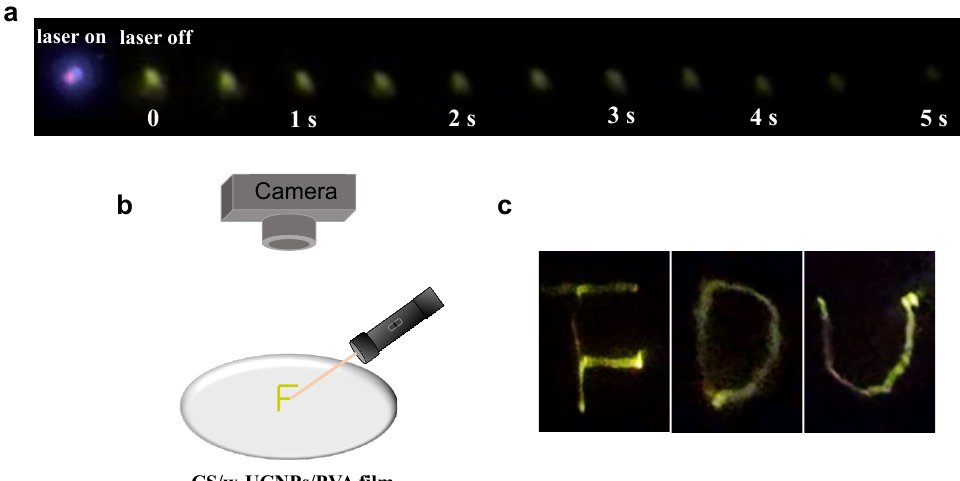
Figure 4. ( a ) Photographs of the long-lasting luminescence of the CS/w-UCNPs/PVA film with the 980 nm laser excitation on and off; ( b ) schematic illustration of laser writing; ( c ) photographs of laser writing of capital letters “F”, “D”, and “U”.